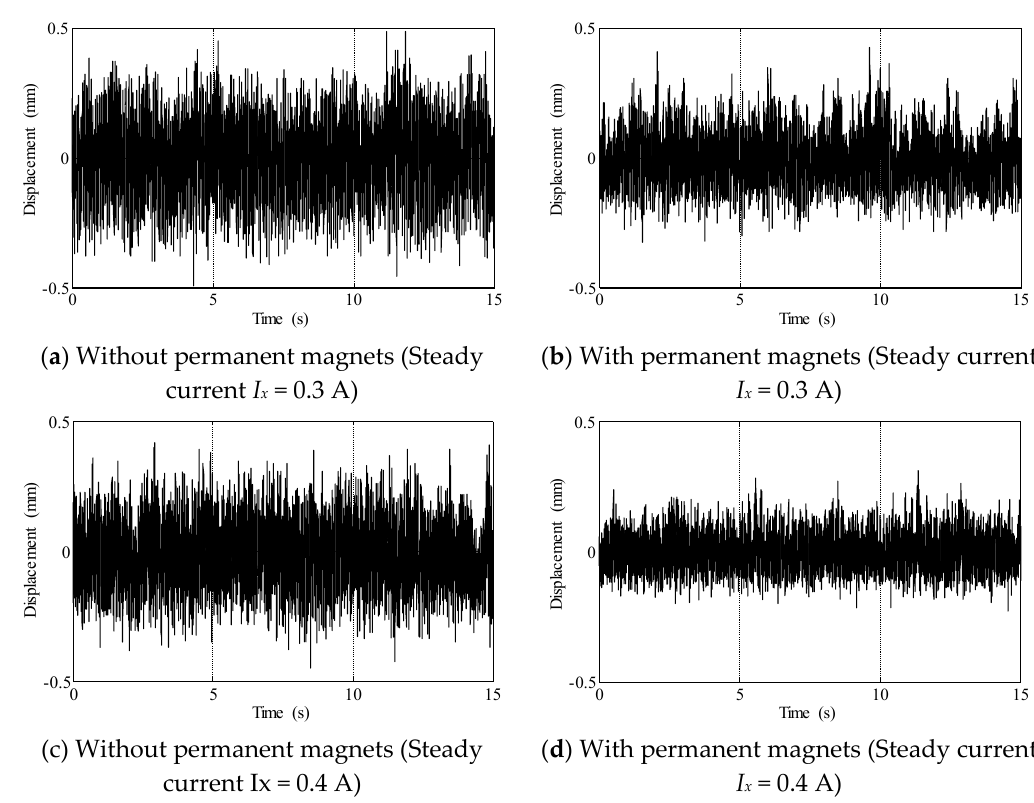
Figure 8. Time history of displacement at each steady current of the horizontal electromagnet.